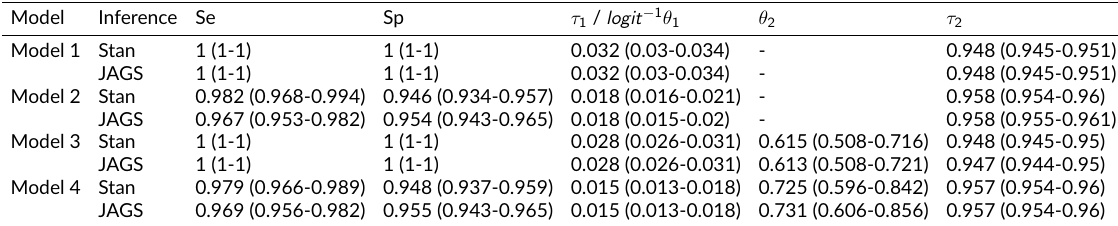
Figure 6 – Traceplots for test sensitivity in Models 1 and 2 estimated in Stan and JAGS. Each color represents one of 4 chains run for each model. Table 3 – Median (2.5%, 97.5%) of the parameter posterior distributions used in the 4 Bayesian models evaluated. Model 1: Perfect routine test; Model 2: Perfect routine test and risk factors; Model 3: Imperfect routine test and risk factors; Model 4: Imperfect routine test, confirmatory testing and risk